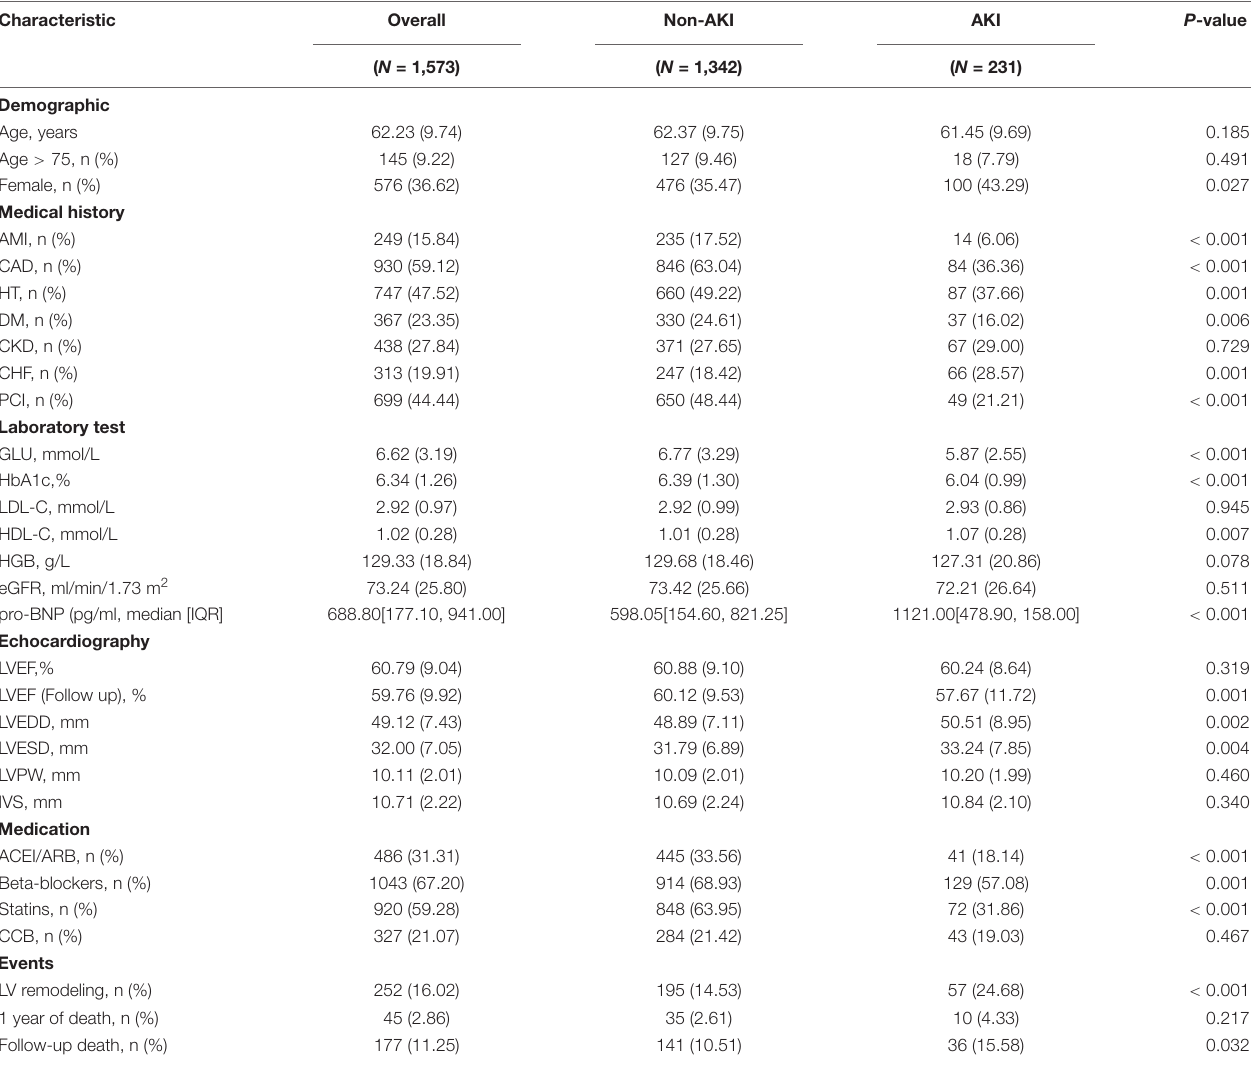
TABLE 1 | Baseline Characteristics According to Categories of